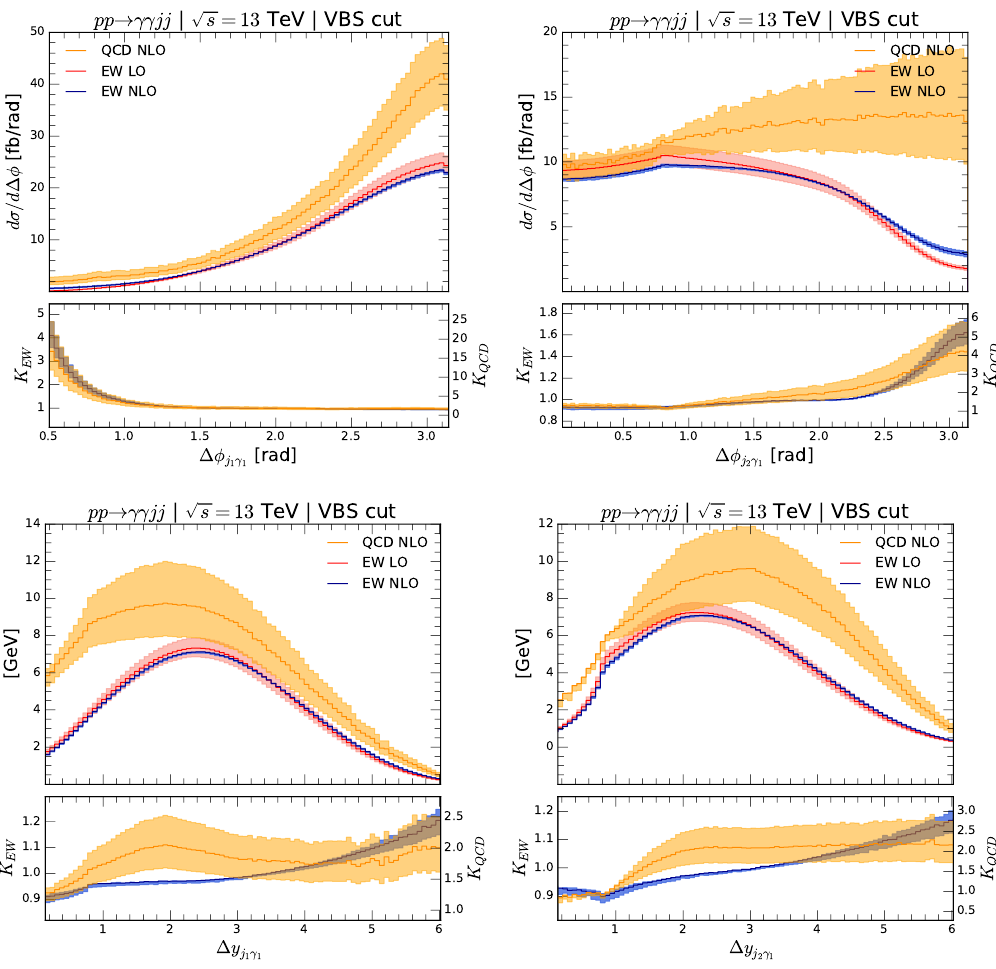
Figure 9 . Distributions of the (cid:30) -separation (top row) and the absolute value of the y -separation (bottom row) between the hardest photon and the tagging jets. The scale-uncertainty bands and K -factors are the same as (cid:12)gure